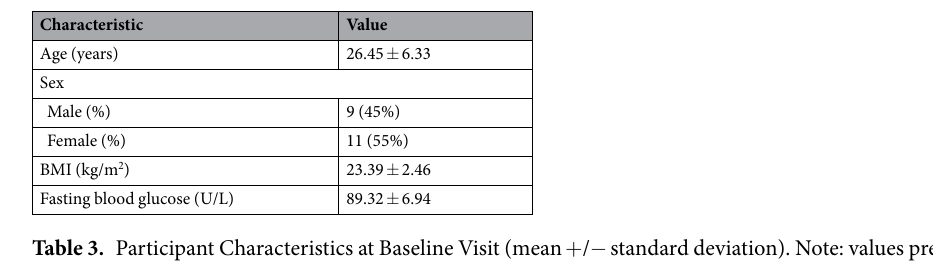
Table 3. Participant Characteristics at Baseline Visit (mean + / − standard deviation). Note: values presented as the mean ± the standard